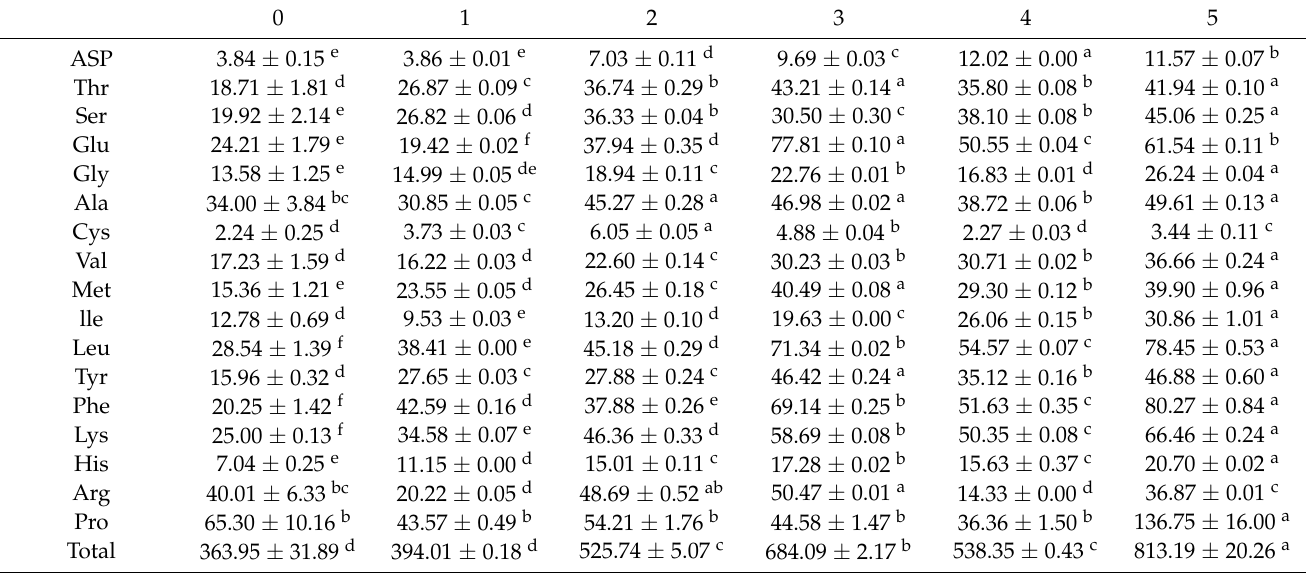
Table 3. Free amino acid content change of cuttlefish flesh that had undergone after freeze–thaw